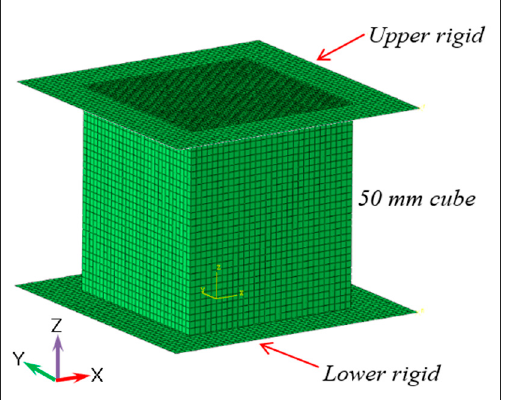
Figure 5. FE modeling of EPS.